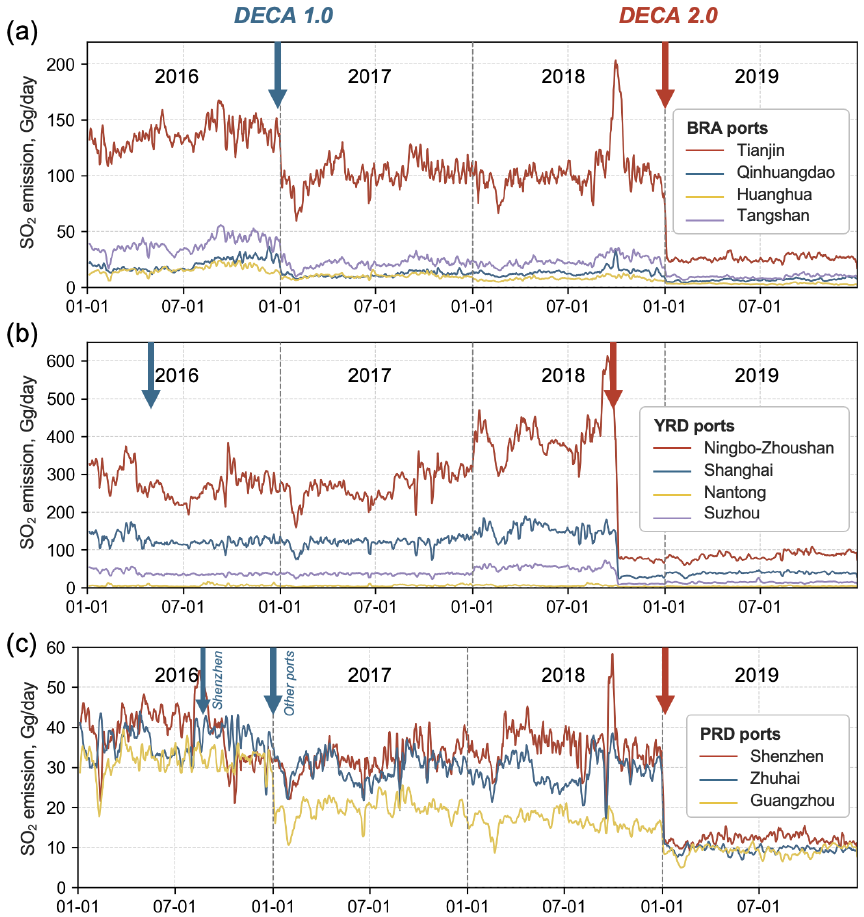
Figure 9. The 5d moving average of SO 2 emissions from ships in major ports of China from 2016 to 2019: (a) Bohai Sea area (BRA), (b) Yangtze River Delta (YRD) and (c) Pearl River Delta (PRD). The blue and red arrows mark the actual implementation dates of DECA 1.0 and DECA 2.0 policies,